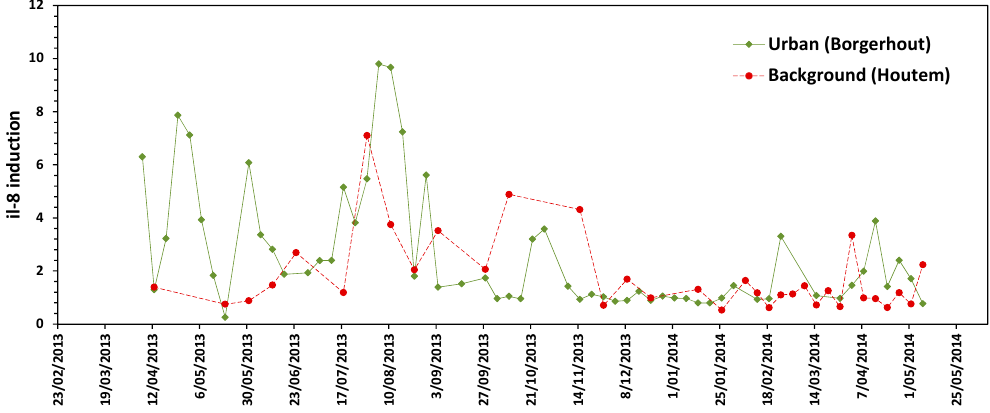
Figure 2. Time series of pro-inflammatory potential of individual PM 10 air samples between April 2013 and May 2014 for each sampling site. IL-8 induction after exposure of Beas-2B cells to 100 µg/mL PM 10 particulate fraction. IL-8 induction is expressed as the ratio between IL-8 production after PM 10 exposure and IL-8 levels in non-exposed cells.